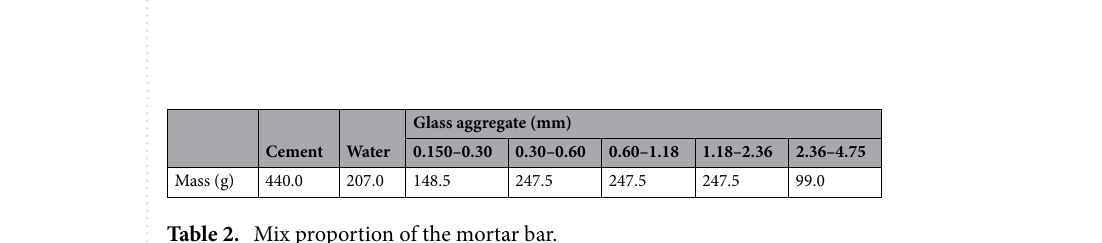
Table 2. Mix proportion of the mortar